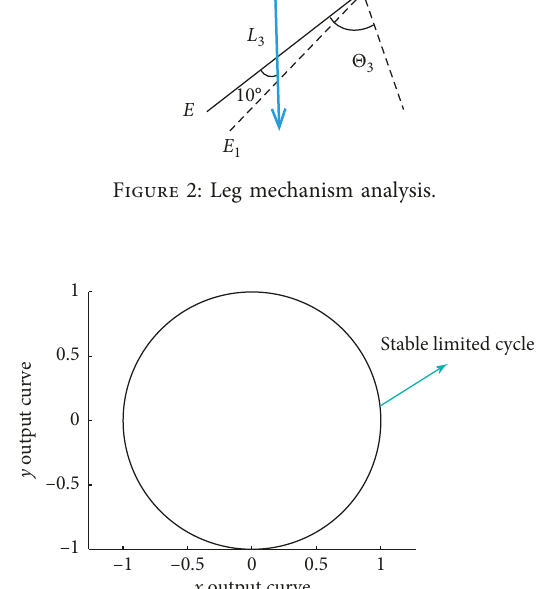
Figure 3: Limit cycles of stability.